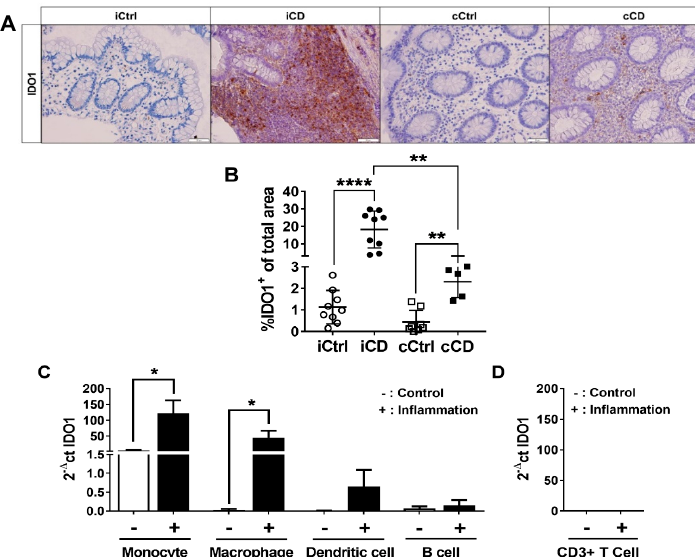
Figure 2. IDO1 expression is increased in the intestinal tissue of patients with active CD. ( A ) Analysis of IDO1 protein expression in paraffin-embedded tissue samples of patients with CD using IHC (representative images, magnification 20×). Inflamed tissue of patients with CD (ileum and colon) were compared to noninflamed control samples. Active inflammation was determined using the Riley score. ( B ) Differential quantitative and localization-dependent evaluation of total IDO1+ area in patients with ileal and colonic CD, compared to control samples. ( C , D ) Distribution and regulation of IDO1 mRNA expression in ( C ) Antigen-presenting cells and ( D ) CD3+ T cells. Antigen-presenting cells and CD3 + T cells were stimulated for 24 h with IFN γ (100 U / mL), TNF α (100 ng / mL) and IL-1 β (10 ng / mL). mRNA expression levels were determined by TaqMan real-time PCR as described in Section 2. ( B – D ) Data are shown as mean ± SD of n = 3–9; * for p ≤ 0.05, ** for p < 0.01, and **** for p < 0.0001 using the ( B ) Mann–Whitney test or ( C , D ) paired Student’s t -test. cCD = colonic CD, cCtrl = colon non-IBD control, iCD = ileal CD, iCtrl = ileum non-IBD